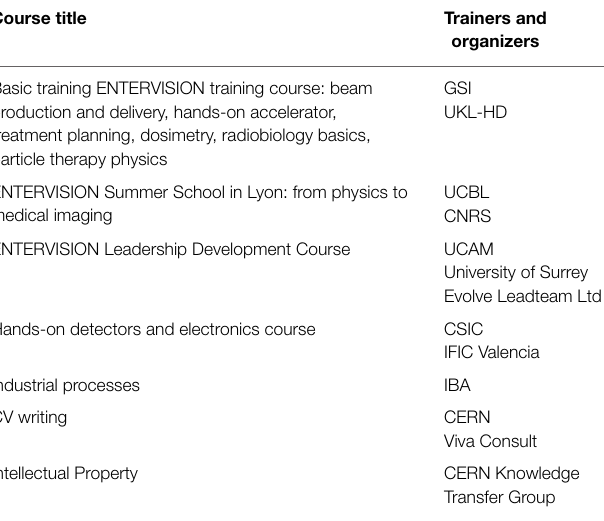
TABLE 2 | ENTERVISION network-wide training courses